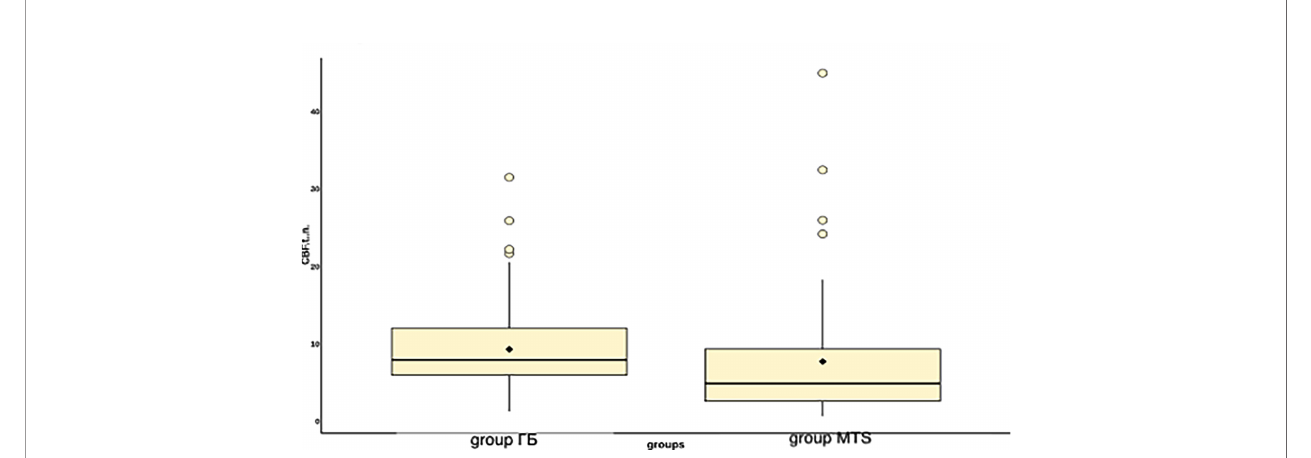
FIGURE 4 | Boxplot displaying blood fl ow values in groups of metastases and